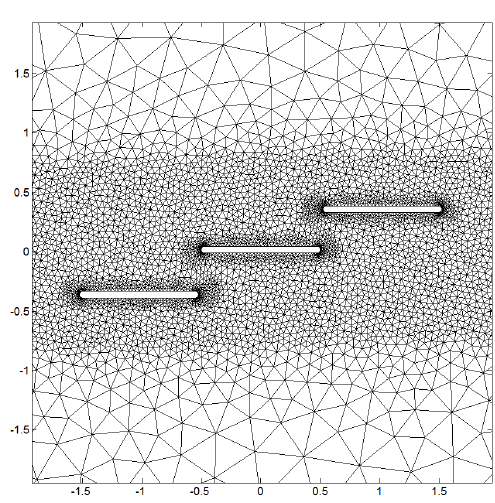
Fig. 3. Detail of computational mesh in the vicinity of simplified